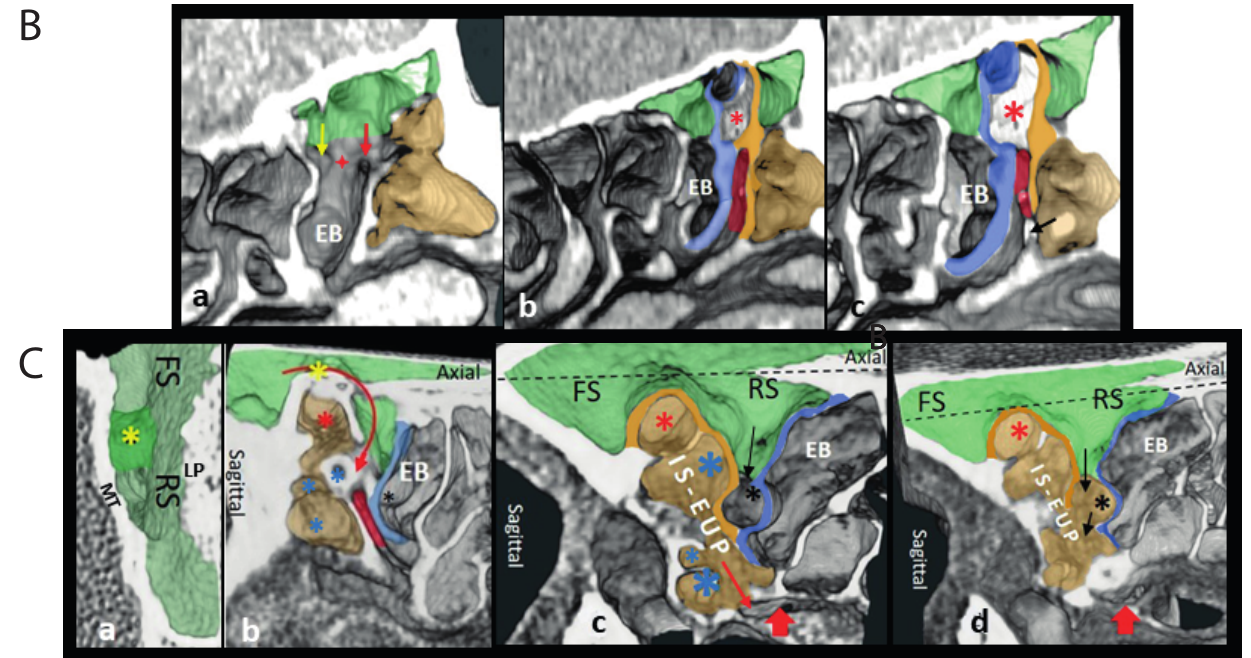
Figure 2. IS-EUP pneumatizes into the Frontal